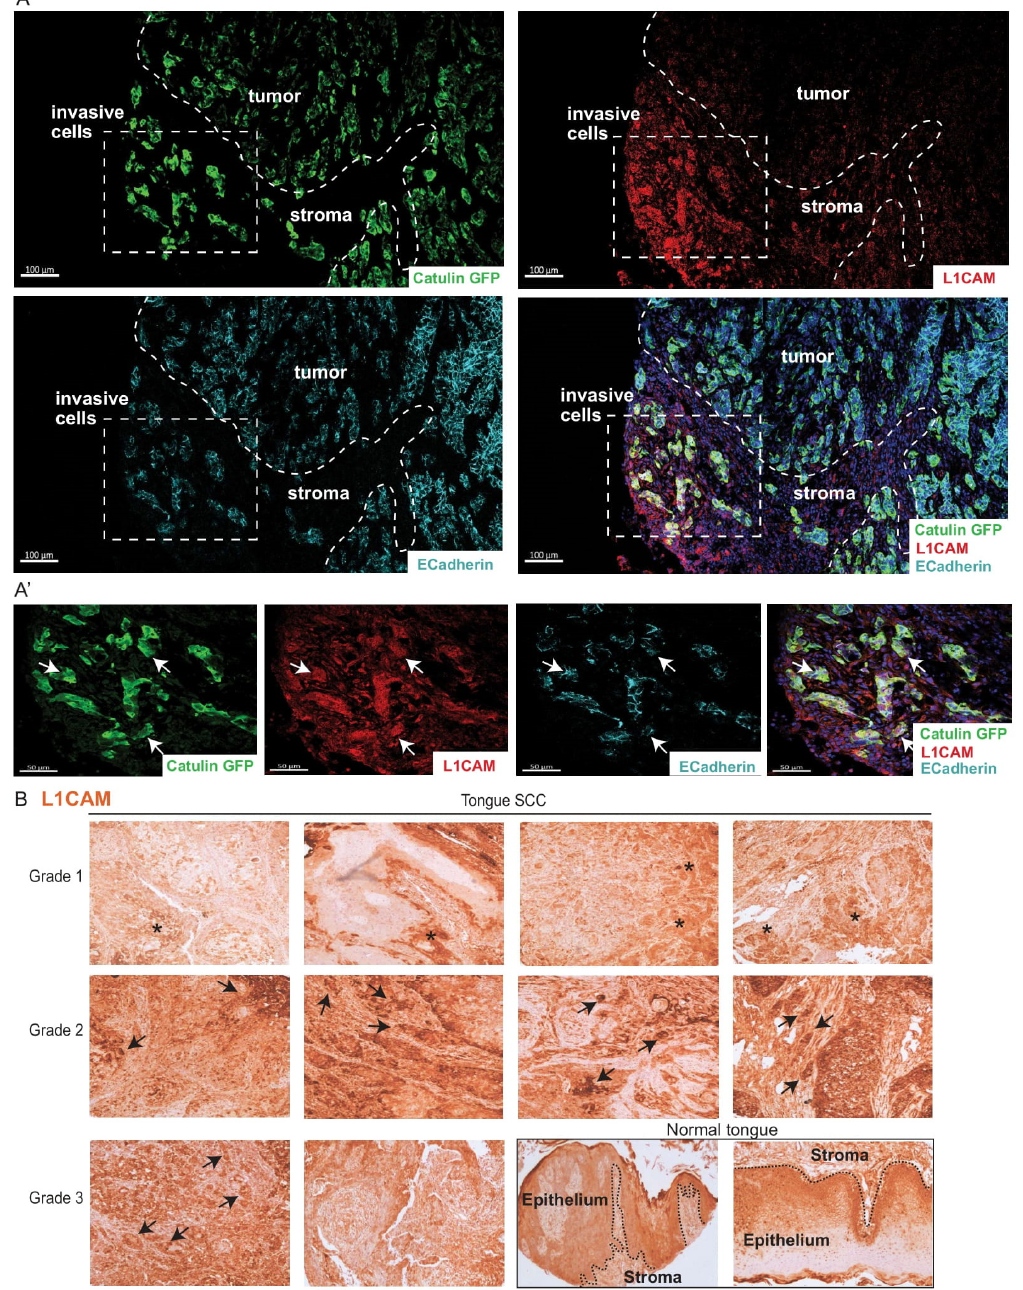
Figure 8. L1 cell adhesion molecule (L1CAM) localization in Catulin-GFP reporter tumor and in human HNSCC cancer tissues. ( A ) Immunofluorescence staining of the section of SCC15CatGFP tumor formed with the injection of SCC15CatGFP and with the use of the L1CAM antibody. GFP (catulin reporter) immunofluorescence is indicated in green, L1CAM immunofluorescence is indicated in red, E-cadherin immunofluorescence is indicated in cyan, and DAPI (nucleus) immunofluorescence is indicated in blue. The boxed area in ( A ) are enlarged in ( A (cid:48) ). Arrows indicate the co-localization of the catulin reporter with L1CAM. The dashed line indicates the tumor–stroma border. Invasive cells are indicated. Scale bar: 200 µ m. ( B ) Immunohistochemical DAB stainings of L1CAM in a tissue array of tongue SCC samples and in normal human tongue tissue. Arrows indicate high L1CAM expression in potentially invasive cells. Asterisks indicate regions with A higher than average level of L1CAM expression. Tumor grade, as provided by the manufacturer, is indicated. The stroma/epithelium border in normal tongue tissue is